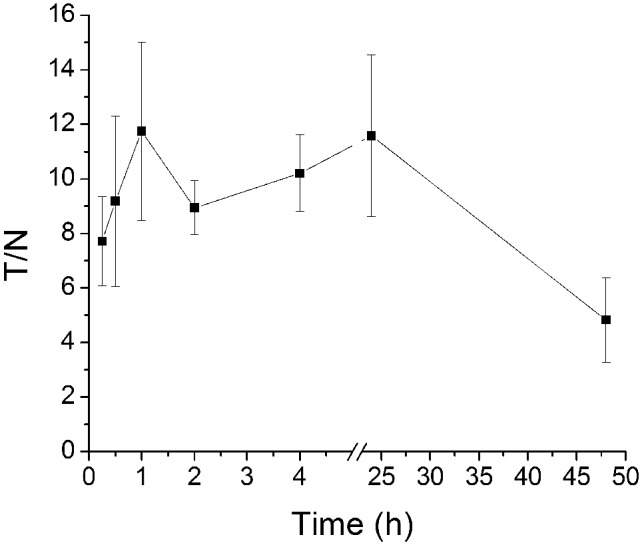
Time dependent tumor/non-tumor (T/NT) ratio of 188Re uptake by U87-hNIS tumor bearing nude mice.Data points are means ± SD (n = 6).